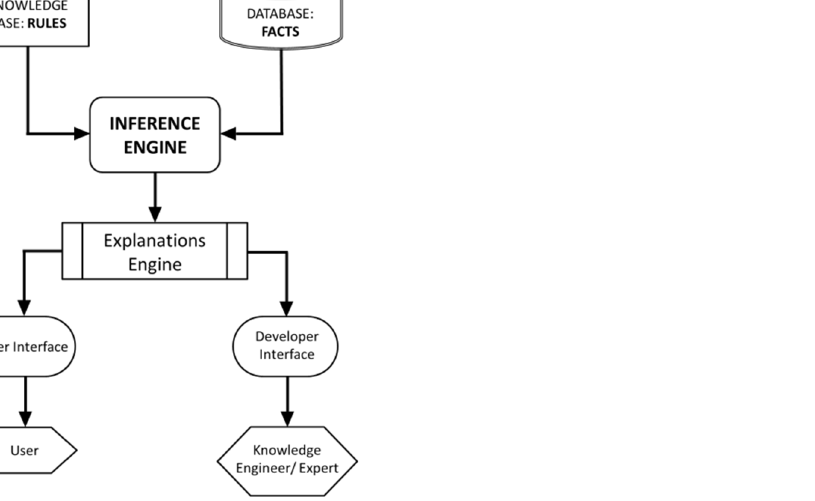
Figure 1. Production-rules expert system architecture. Note. This graphic describes an expert system according to the authors’ definition and visualization. See [19] for a similar depiction.